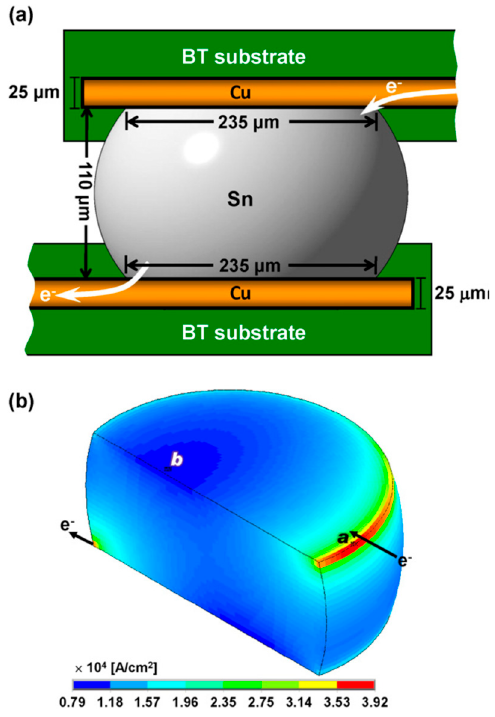
Figure 1. ( a ) Schematic illustration of the material configuration and dimensions of the line-bump-line solder joint. ( b ) Simulation of the current density distribution in the solder region of the Cu/Sn/Cu joint Reprinted with permission from Ref. [34] Copyright 2015 Elsevier.